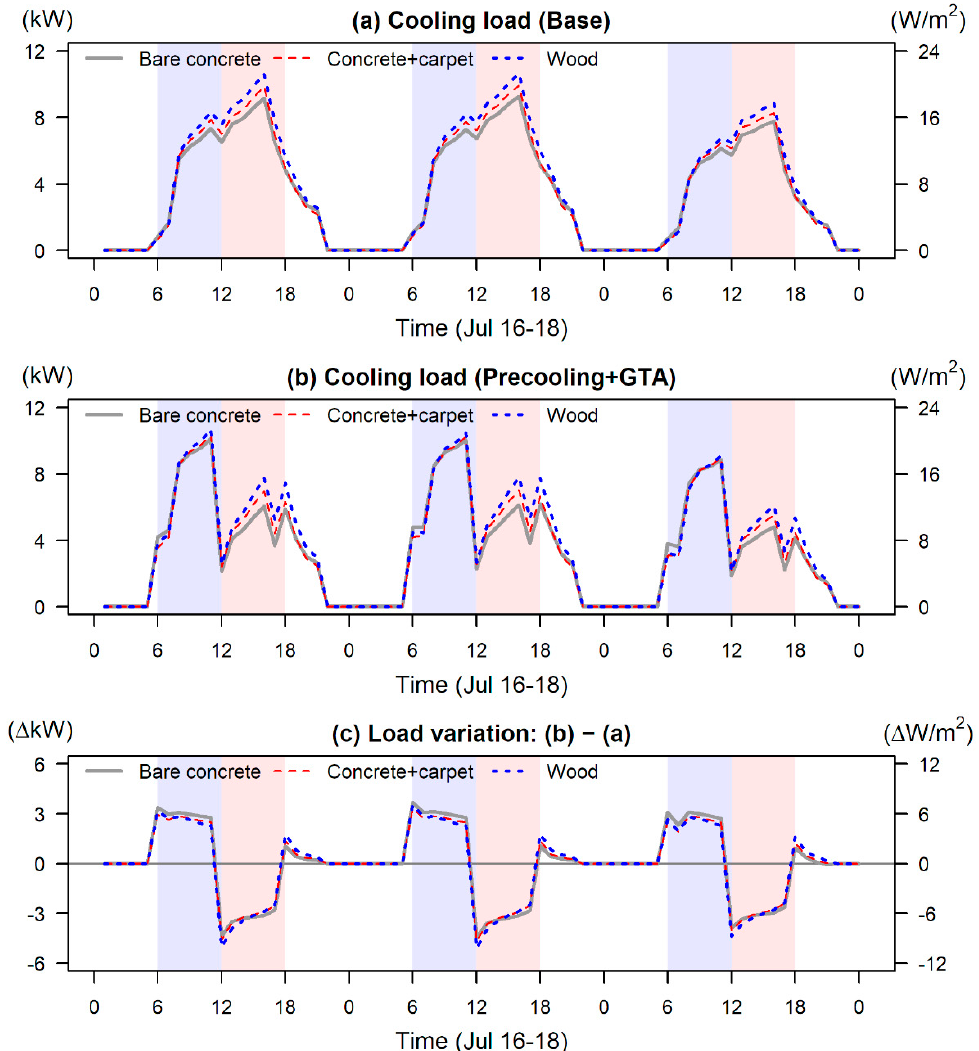
Figure 6. Hourly cooling loads for three floor configurations: Bare concrete, Concrete + carpet, and Wood under ( a ) Base and ( b ) Precooling + GTA scenarios, and ( c ) variations in hourly cooling loads between the two scenarios during 16–18 July in San Francisco, CA. The blue-shaded area indicates the morning or precooling period while the red-shaded area indicates the afternoon or GTA period.